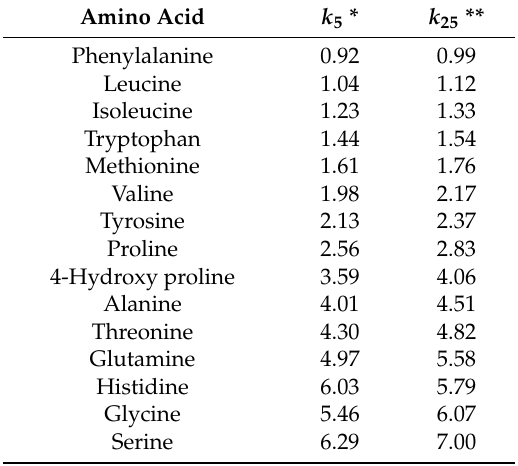
Table 2. Effect of buffer concentration on retention factors of amino